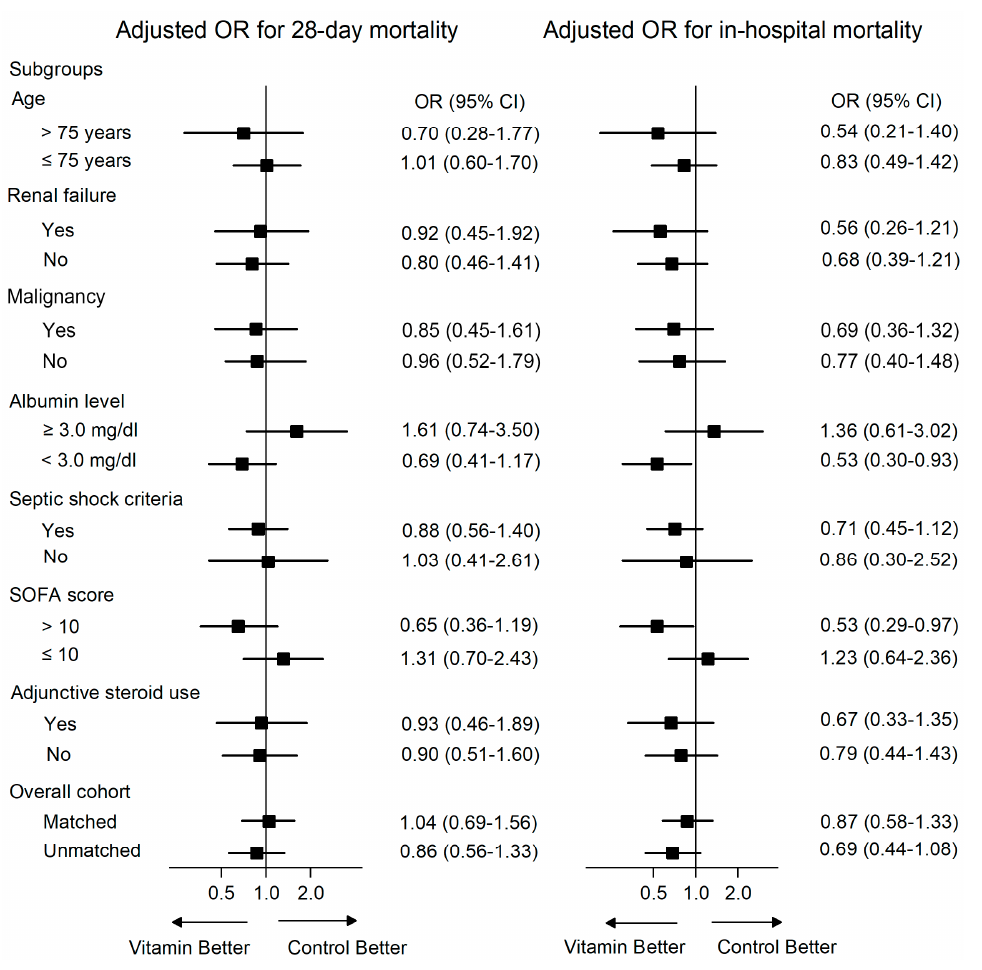
Figure 1. Random-effects multivariate analysis of 28-day and in-hospital mortality in unmatched subgroups.